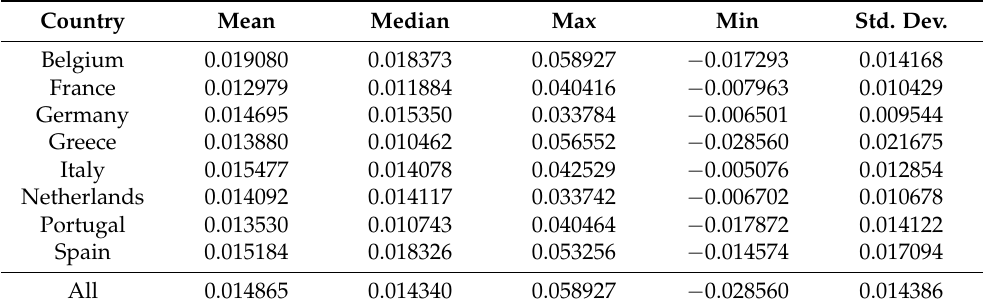
Table A4. Descriptive statistics for inflation rate by